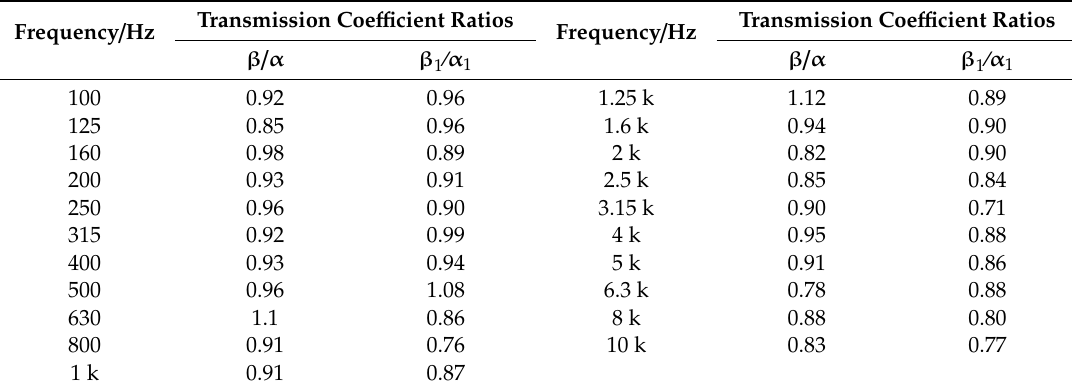
Table 6. Transmission coe ffi cient ratios at di ff erent frequencies.